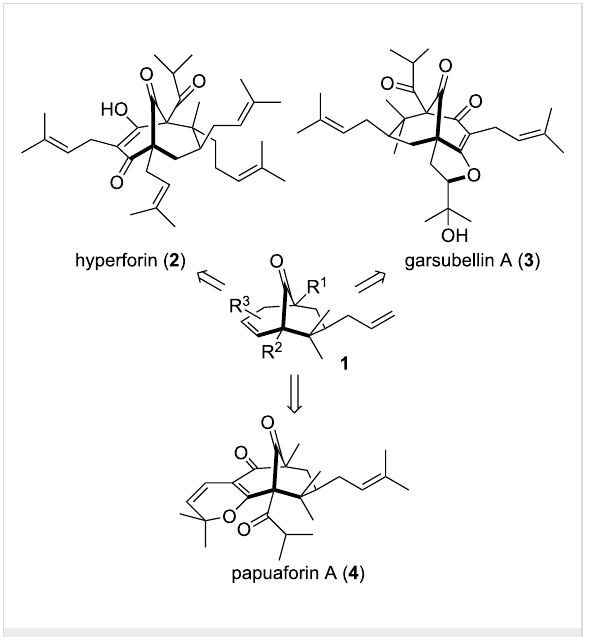
Figure 1: Structures of naturally occurring PPAPs.